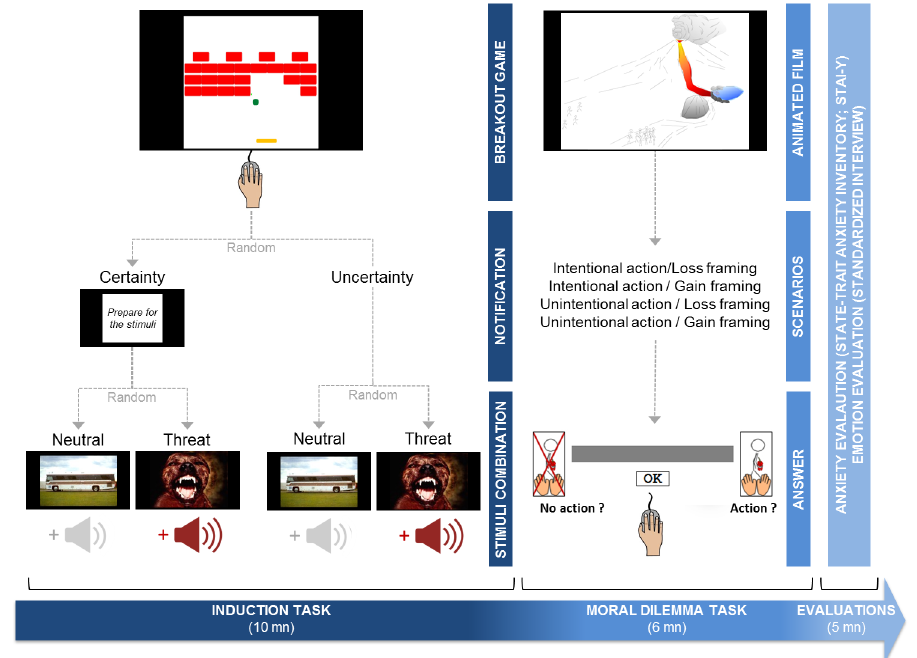
Fig 1. Time course of the experimental design, including the induction task, the moral dilemma task, and the anxiety and emotion evaluations.